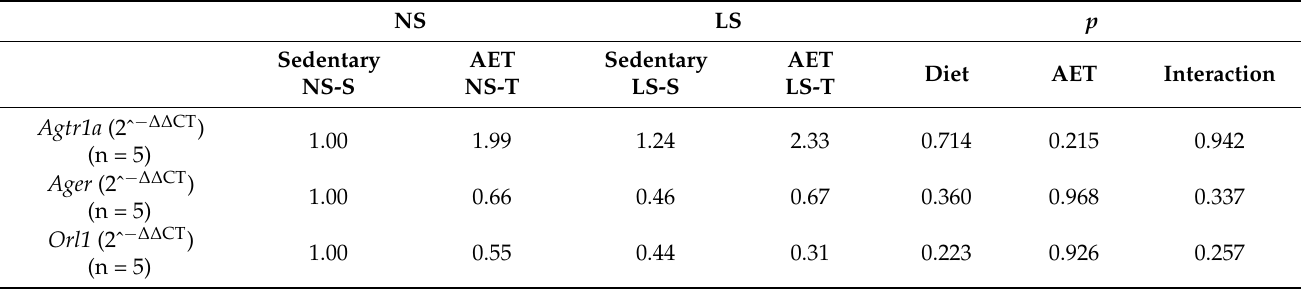
Table 2. The expression of Agtr1a , Ager, and Orl1 genes in LDLR KO mice fed either a normal-sodium (NS) or a low-sodium (LS) diet, trained (T) or sedentary (S), after 90 days. NS LS p Sedentary AET Sedentary AET Diet AET NS-S NS-T LS-S LS-T